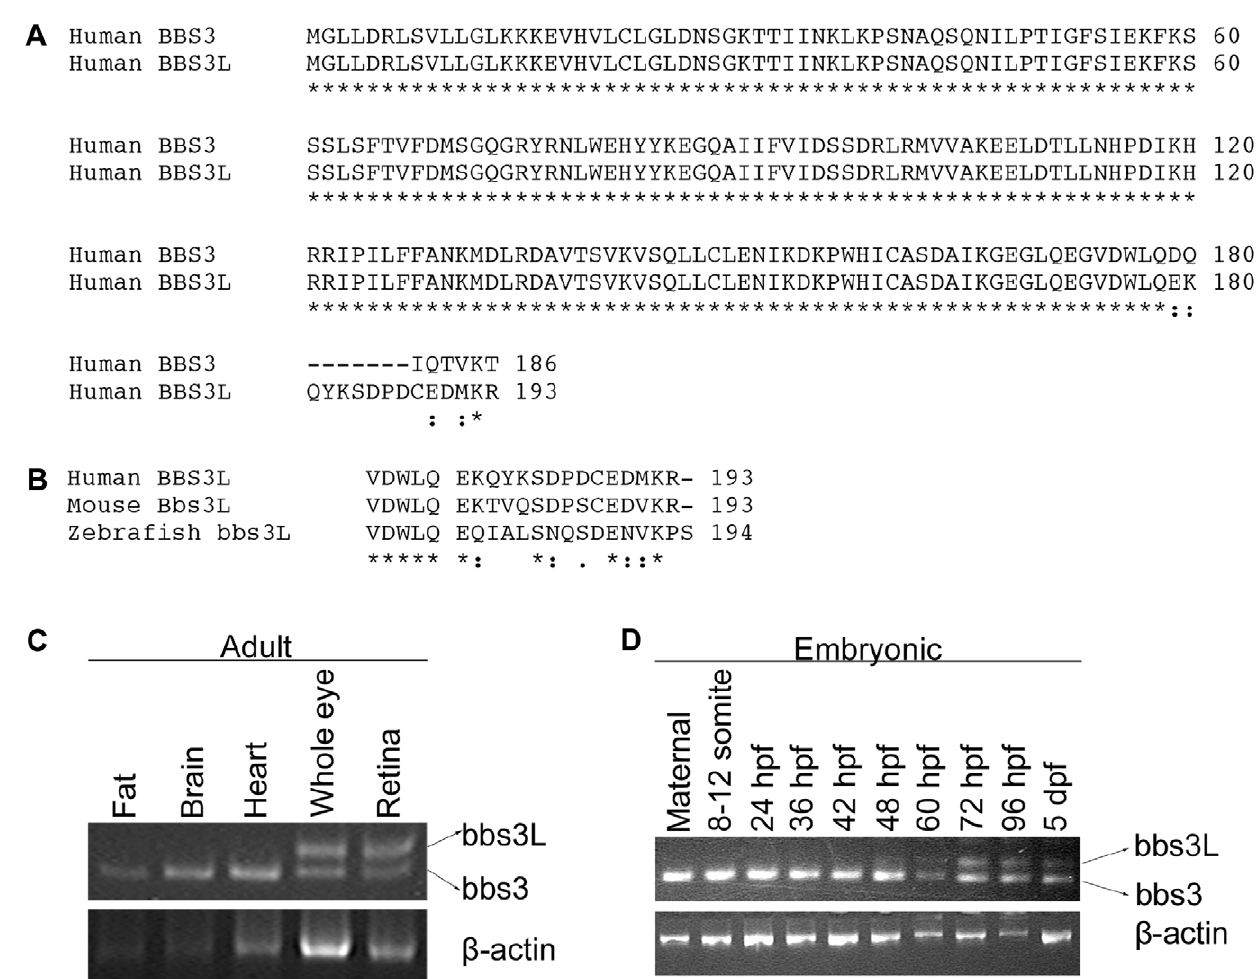
Figure 1. Identification of a second BBS3 transcript. (A) Alignment of human BBS3 and BBS3L proteins. (B) C-terminal end alignment of human, mouse, and zebrafish BBS3L protein. Asterisks (*) indicate identical amino acids shared in all alignments, while colons (:) and periods (.) represent conserved amino acids. (C) RT–PCR tissue expression profile of zebrafish bbs3 and bbs3L transcripts in wild-type adult zebrafish tissues: fat, brain, heart, whole eye and retina. b -actin was used as a positive control. bbs3 is expressed in all adult tissues examined, while bbs3L expression is limited to the eye. (D) RT–PCR developmental expression profile of bbs3 and bbs3L at the following stages: maternal, 8–12 somites, 24, 36, 42, 48, 60, 72, 96 hpf, and 5 dpf. bbs3 is expressed throughout development, while the long form is only present by 48 hpf, correlating with photoreceptor development.